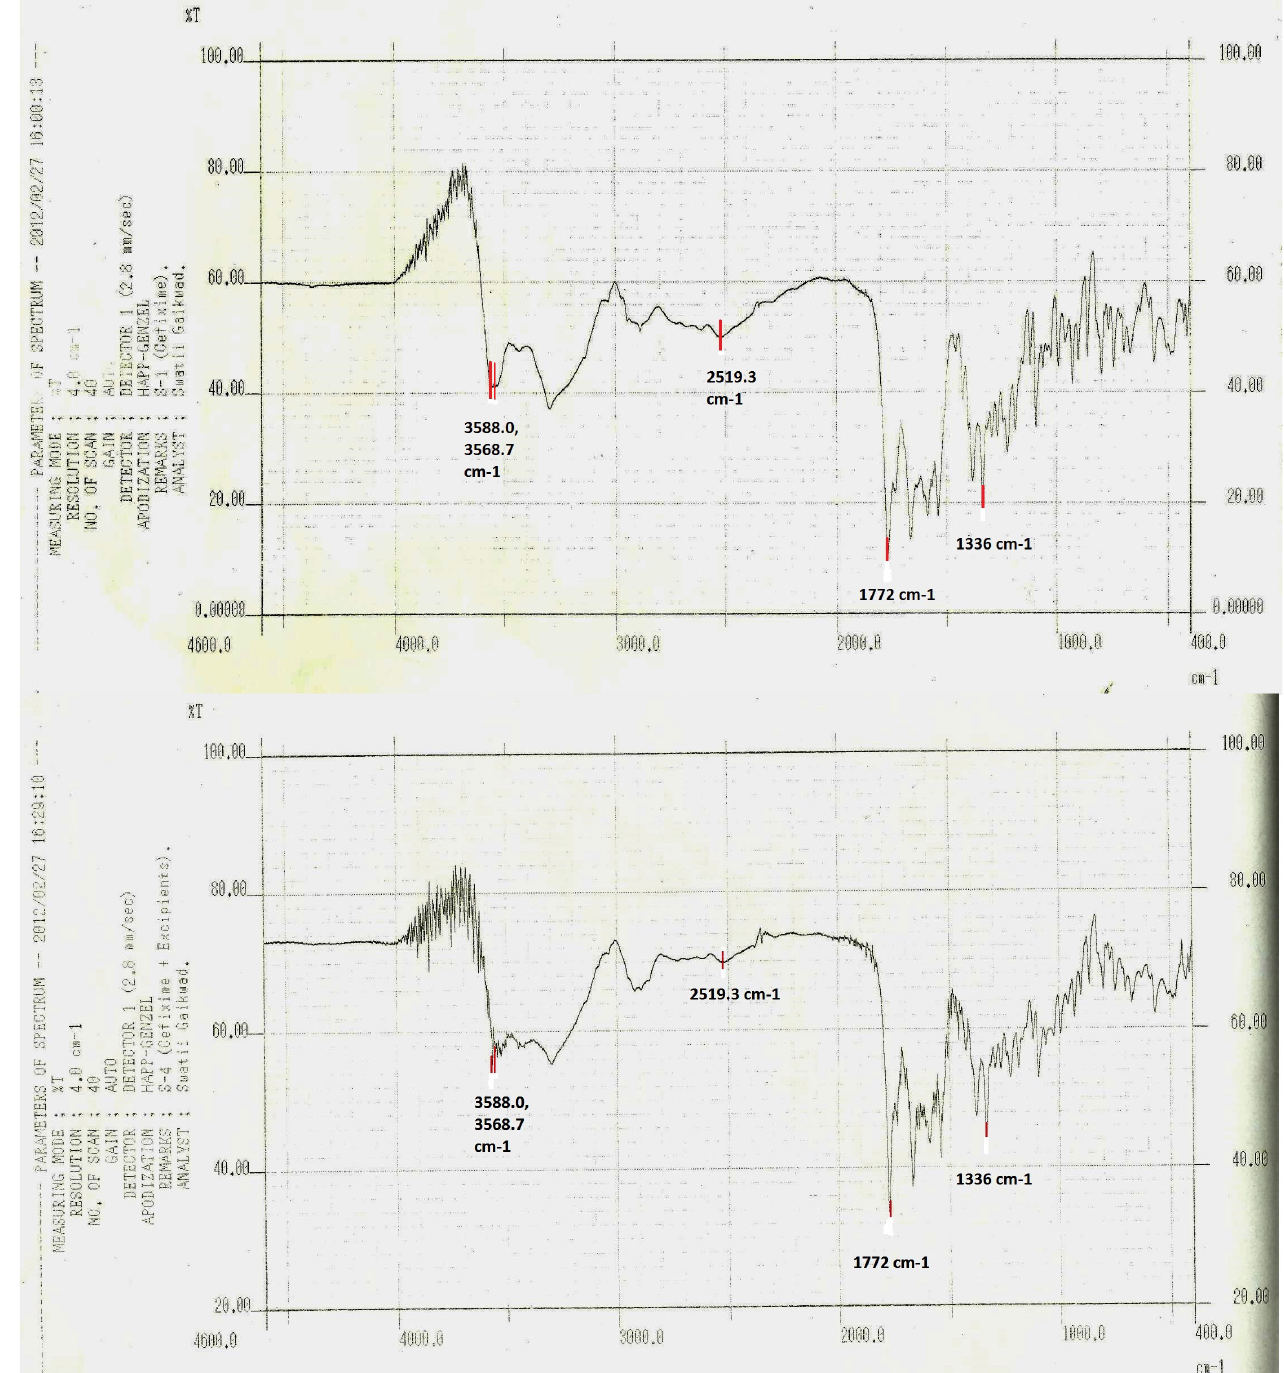
FIGURE 1 - Infra red (FT-IR) spectrum of cefixime trihydrate and cefixime trihydrate with excipients. tablets formulated from the blend of C8 formula have shown the disintegration time of 30 sec. In-vitro dissolution study of bilayer tablets were performed using USP type I apparatus (Table 7 & 8 show the percent drug release)and amount of drug released was calculated simultaneously using HPTLC (representative